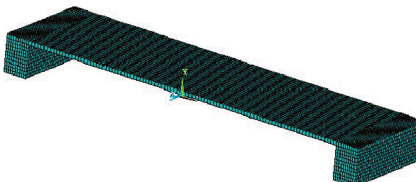
Figure 8: Detailed solid element model.